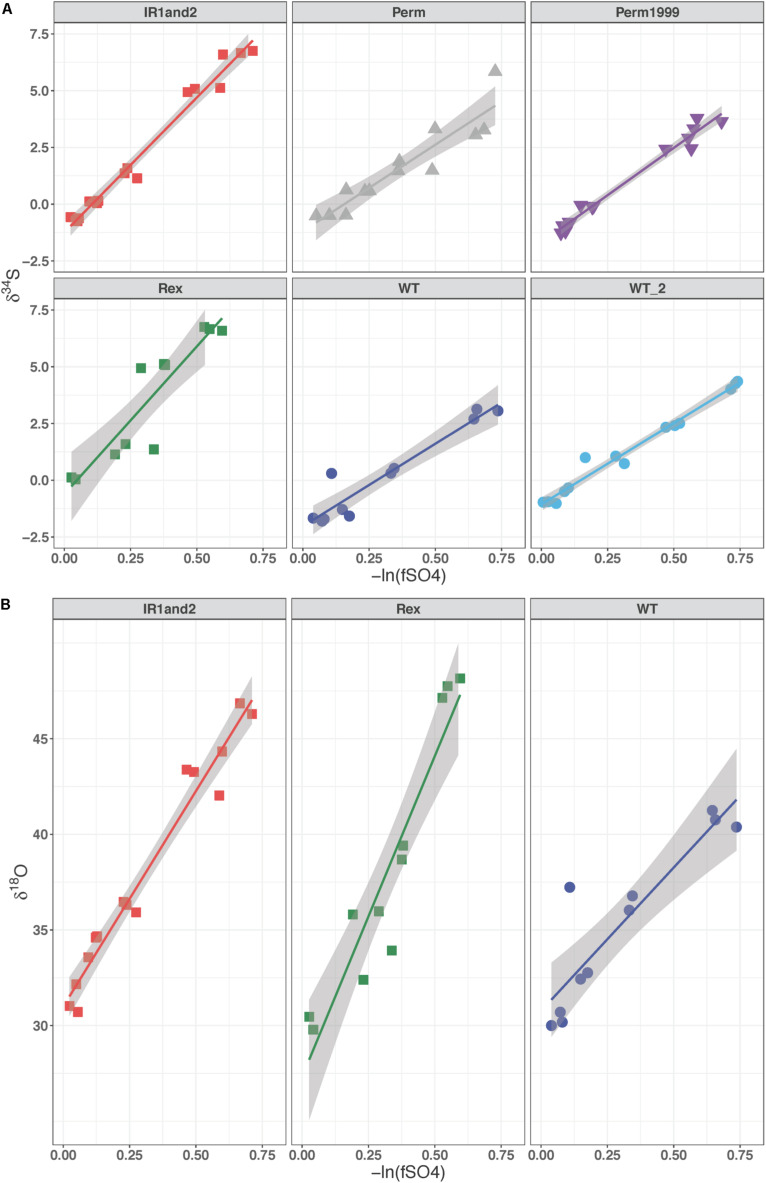
(A) δ34S of residual sulfate plotted against the negative natural logarithm of the fraction of reactant sulfate remaining for the Permease and Rex mutant batch experiments. (B) δ18O of residual sulfate plotted against the negative natural logarithm of the fraction of reactant sulfate remaining in the Rex mutant experiments. The slope of these lines represents the fractionation factor (ε) and is plotted with the 95% confidence interval for the regression.